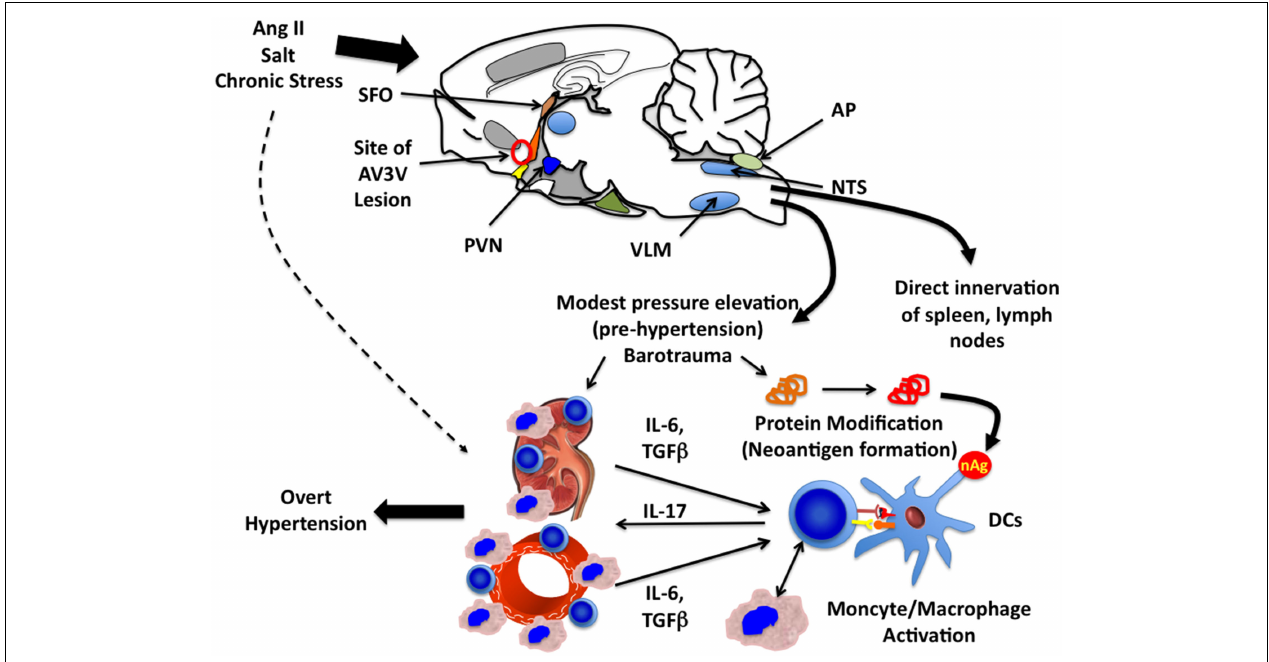
pre-hypertension. Sympathetic stimulation also increases renal production of IL-6 and acts onT cell adrenergic receptors to modify their polarization.The elevations of pressure, direct actions and angiotensin II and catecholamines activate ROS production in the kidney and vasculature, increasing chemokine production and adhesion molecule expression.We propose that neoantigens (nAg) are formed from endogenous proteins in the kidney and vasculature, which are presented by dendritic cells toT cells. ActivatedT cells interact with monocyte/macrophages, promoting macrophage transformation and these leukocytes accumulate in the kidney. IL-6 andTGF β , produced in these organs, help directT cell IL-17 production. IL-17 and other cytokines produced by these cells promote ROS production in the vascular smooth muscle and kidney, leading to vasoconstriction, sodium retention, and ultimately severe